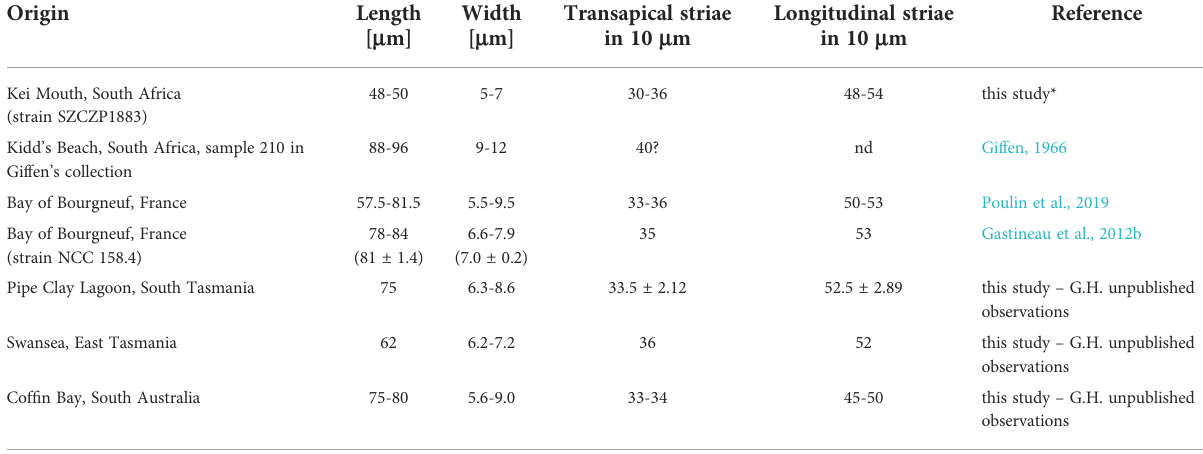
TABLE 1 Valve morphometry of different populations of Haslea ostrearia